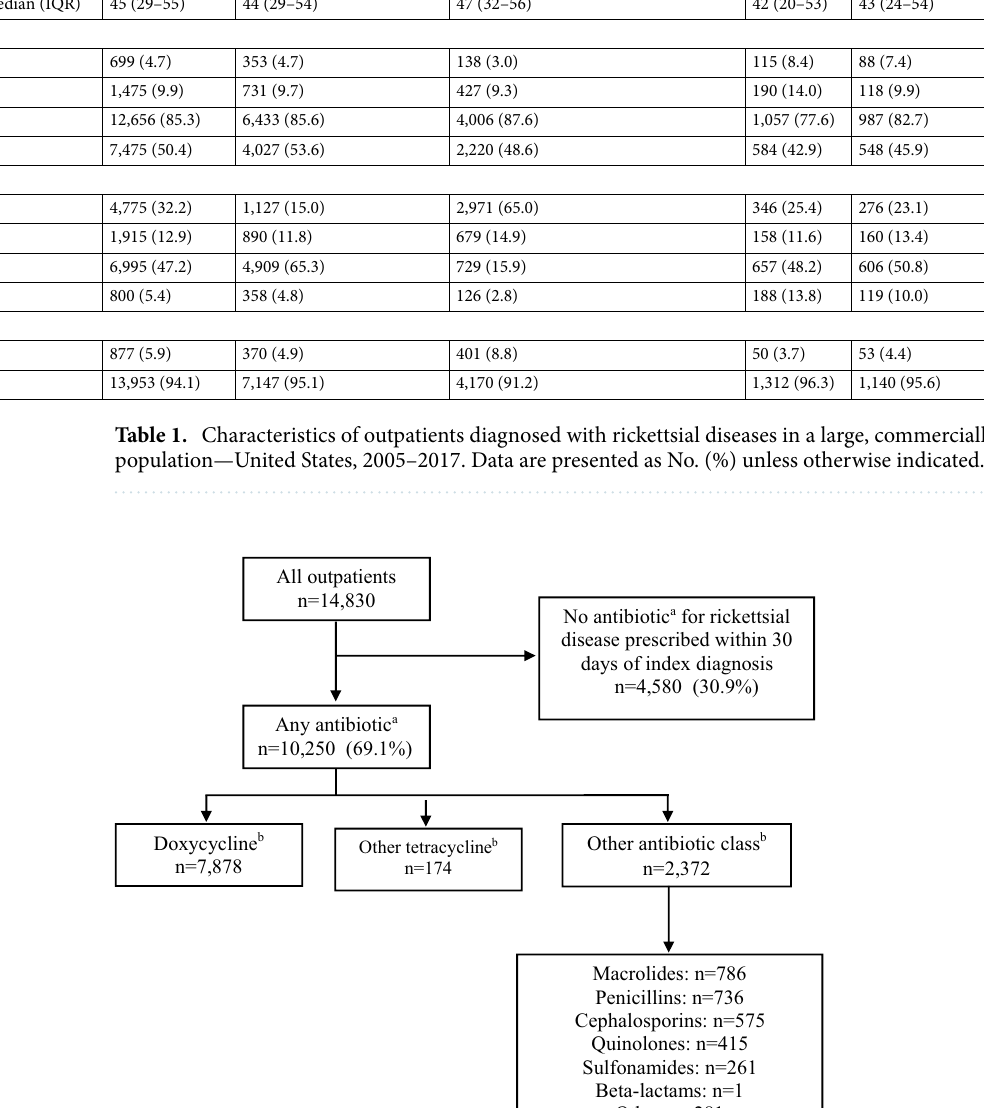
Figure 2. Outpatients diagnosed with a rickettsial disease treated with antibiotics within 30 days of index rickettsial disease diagnosis date in a large, commercially insured population — United States,